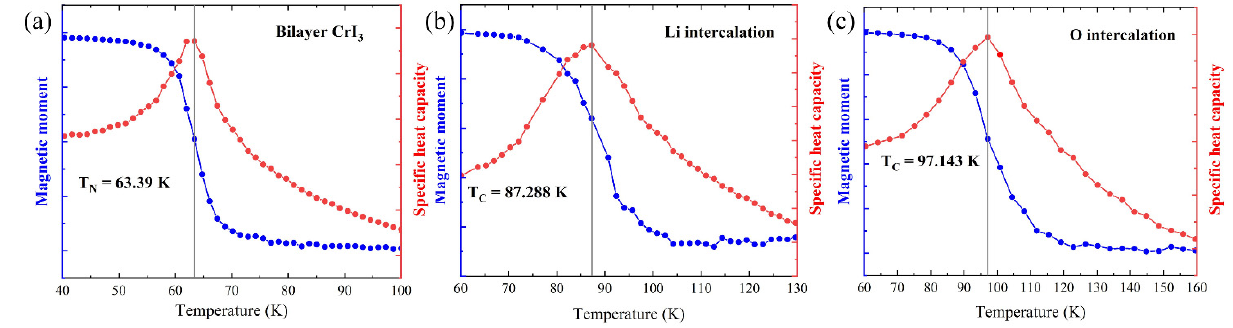
Figure 4. Magnetic moment and specific and specific heat capacity versus temperature in ( a ) pristine CrI 3 bilayer, ( b ) Li intercalation, and ( c ) O intercalation by Monte Carlo simulation.